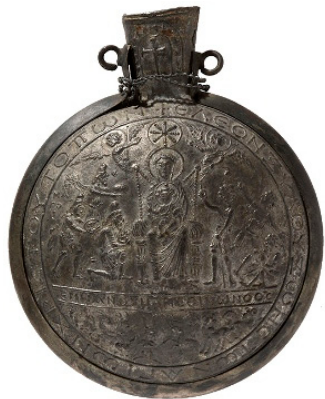
Figure 26. Ampulla n°1 of Monza, obverse. © Treasury of Monza Cathedral (with kind permission).